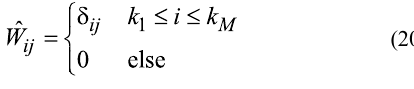
Figure 1 that only polynomial coefficients of odd order contribute to the force measured in the resonant detection band when two drives close to resonance are used in ImAFM. Thus, Equation 19 only yields the odd coefficients in the polynomial force expansion and the resulting polynomial force is odd with respect to z = h . To determine the missing even coefficients we assume that the tip–surface force is zero for z ≥ z non–interacting . With this assumption we fit the even polynomial coefficients while keeping the odd coefficients constant. This reconstruc- tion method has been extensively tested and its accuracy veri- fied with simulated data [19]. In the following we will show results for experimental